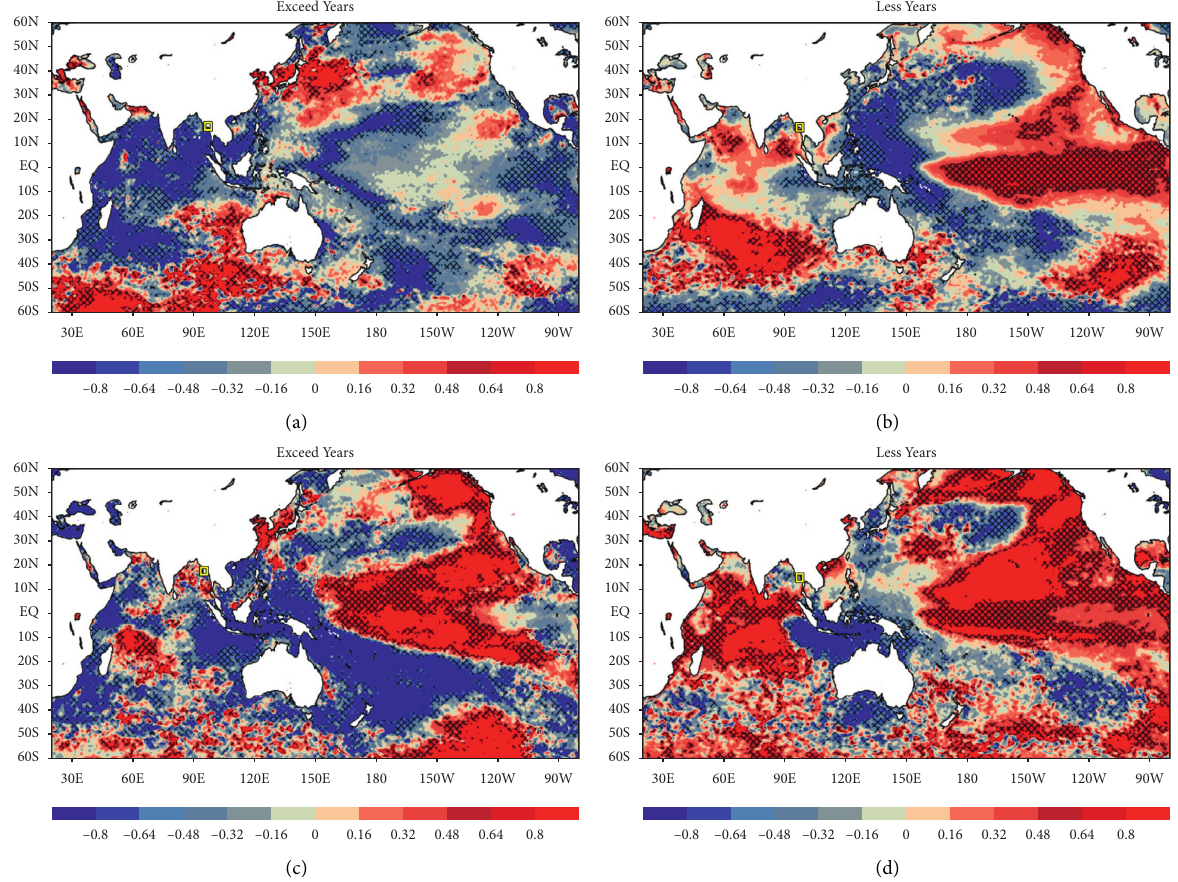
Figure 18: Correlation of SSTwith convective rainfall over the VYYY (shaded) and significant area (hatch) of (a) annual of exceeding years, (b) annual of less years, (c) summer (JJAS) of exceeding years, and (d) summer (JJAS) of less years based on Figure 17 during 1991–2020 at a 95% confidence